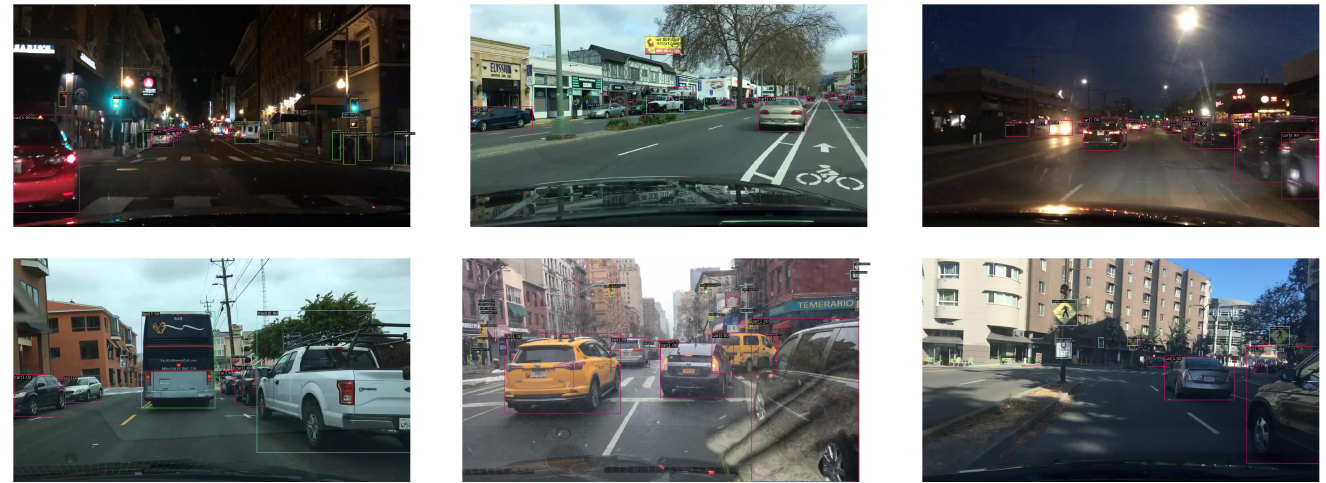
Figure A4. Examples of our PLG-ViT with Faster RCNN [55] on BDD100K